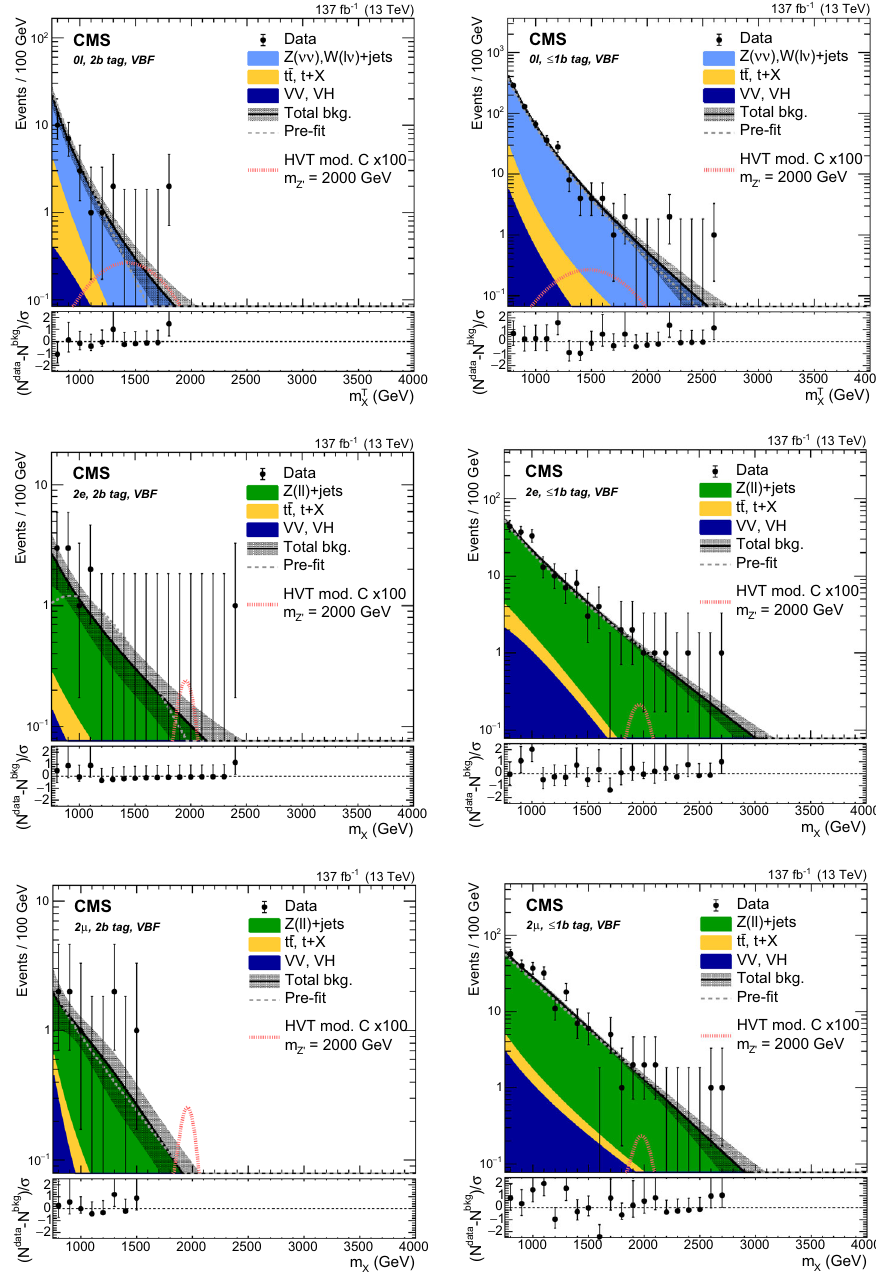
Fig. 6 Distributions in data in the 2b tag (left column) and ≤ 1b tag (right column) VBF categories, of m T for 0 (cid:4) (upper X row), and m X for 2e (middle row), and 2 μ (lower row). The distributions are shown up to 4000GeV, which corresponds to the event with the highest m X or m T observed in the SR. The X shaded bands represent the uncertainty from the background estimation. The observed data are represented by black markers, and the potential contribution of a resonance produced in the context of the HVT model C at m Z (cid:3) = 2000GeV is shown as a dotted red line. The bottom panel shows ( N data − N bkg )/σ for each bin, where σ is the statistical uncertainty in